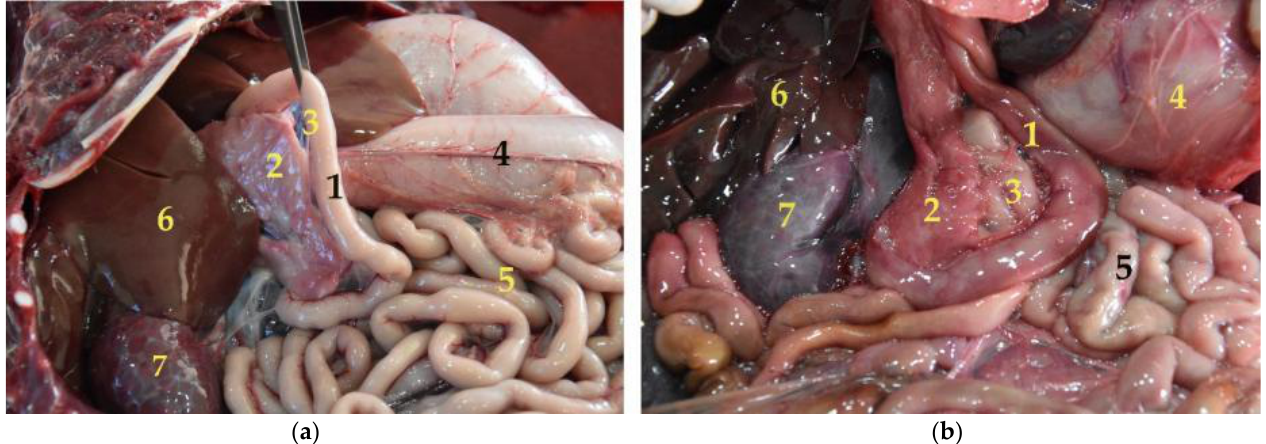
Figure 15. ( a,b ) Pancreas and duodenum in situ (body in dorsal recumbency). Note how they are intimately related. In ( b ) the stomach is displaced to visualize both viscera. ( 1 ) Duodenum; ( 2 ) pancreas; ( 3 ) mesoduodenum; ( 4 ) stomach; ( 5 ) jejunum; ( 6 ) liver; ( 7 ) right kidney.